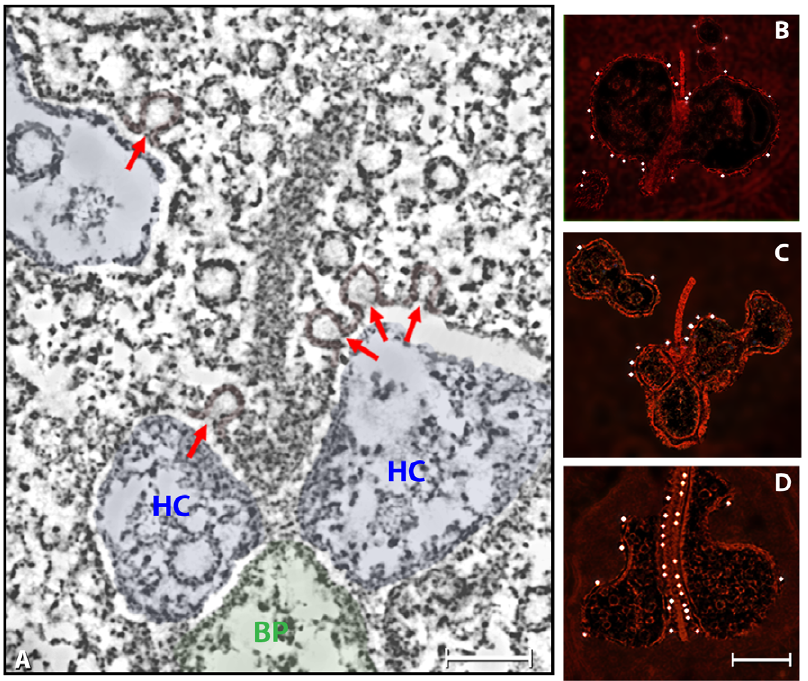
Figure 6. Distribution of fully fused vesicles or omega figures. Panel A shows a plane from the reconstruction of a ribbon synapse from a mouse dark-adapted for 15 minutes. The omega figures are located at the base of the ribbon and along the slope of the synaptic ridge, as well at ribbon-free sites. HC and BP indicate horizontal endings and bipolar cell dendrites, respectively. Panels B–D show the localization of omega figures (white dots) at ribbon-associated (panel B) and ribbon-free regions of the rod spherule (panels C–D). Bar: 60 nm.